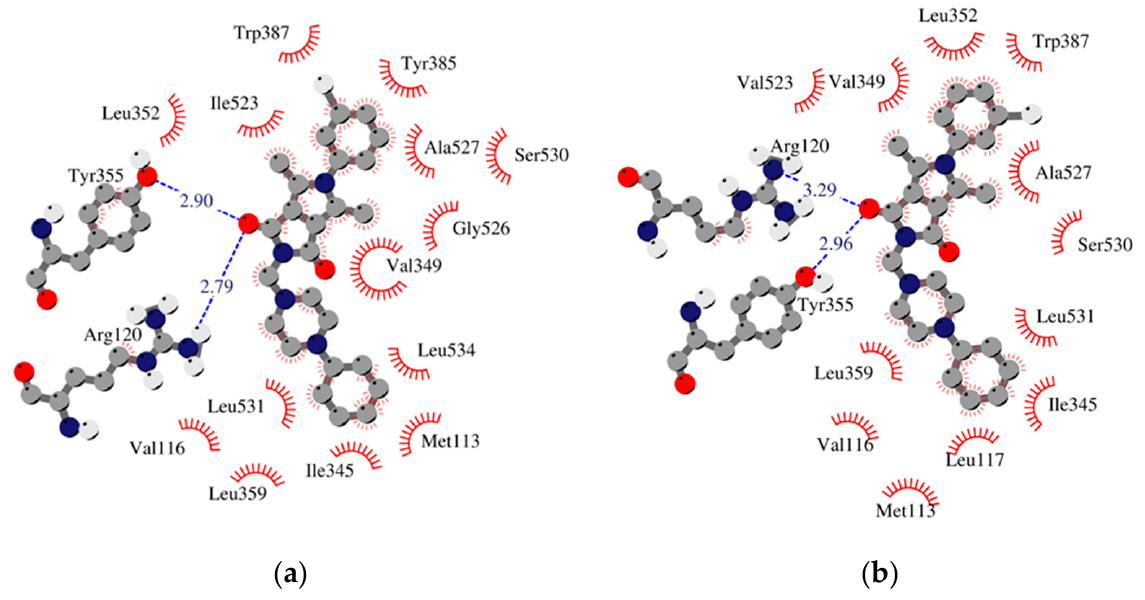
Figure 4. Schematic 2D diagrams of protein–ligand interactions 2h . Hydrophobic contacts are represented by an arc with spokes radiating towards the ligand atoms they contact. Free enthalpy of binding: ( a ) COX-1_h2 − 10.53 [kcal/mol], ( b ) COX-2_h2 − 11.92